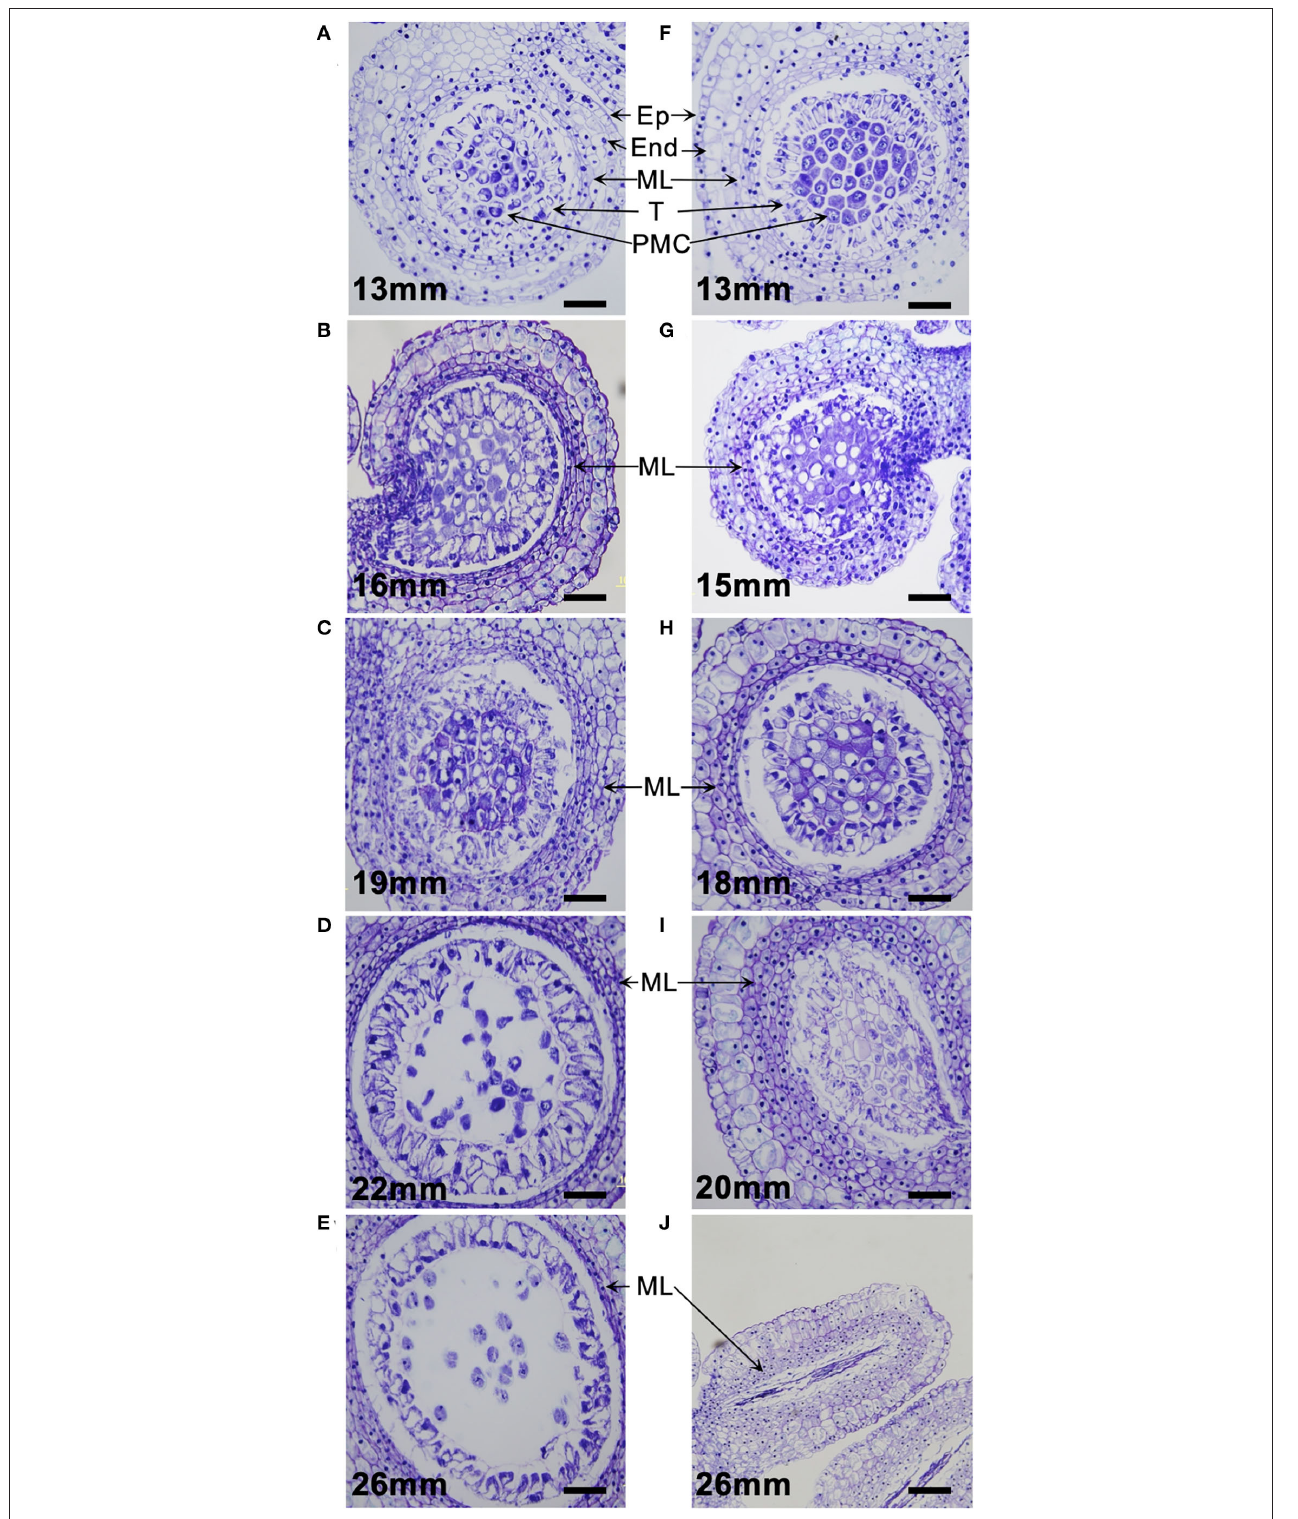
FIGURE 2 | Microsporogenesis of L . × formolongi . (A–E) Pollen-fertile segregants. (F–J) Pollen-sterile segregants. Ep, epidermis; End, endothecium; ML, middle layers; T, tapetum; PMC, pollen mother cells. Bar = 100 µ m.